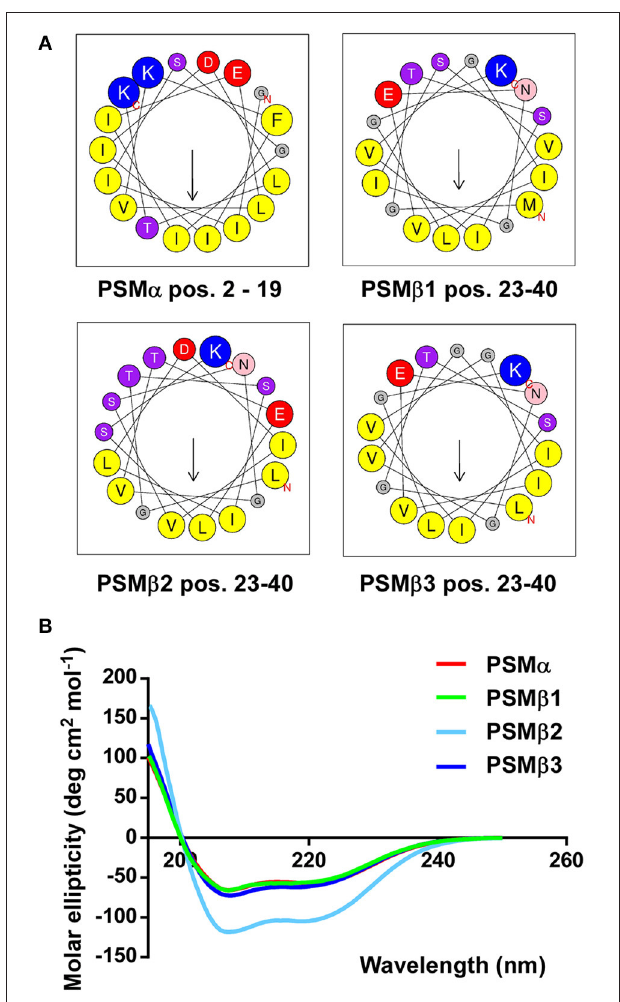
FIGURE 4 | S. haemolyticus PSMs form amphipathic α -helices. (A) Computation of α -helical wheels in the α -helical part of the peptides (using the program available at http://heliquest.ipmc.cnrs.fr). Note opposite arrangement of hydrophobic (yellow) vs. charged (red, blue) and hydroxyl (purple) amino acids. (B) Circular dichroism spectra of peptides in membrane environment conditions (50%